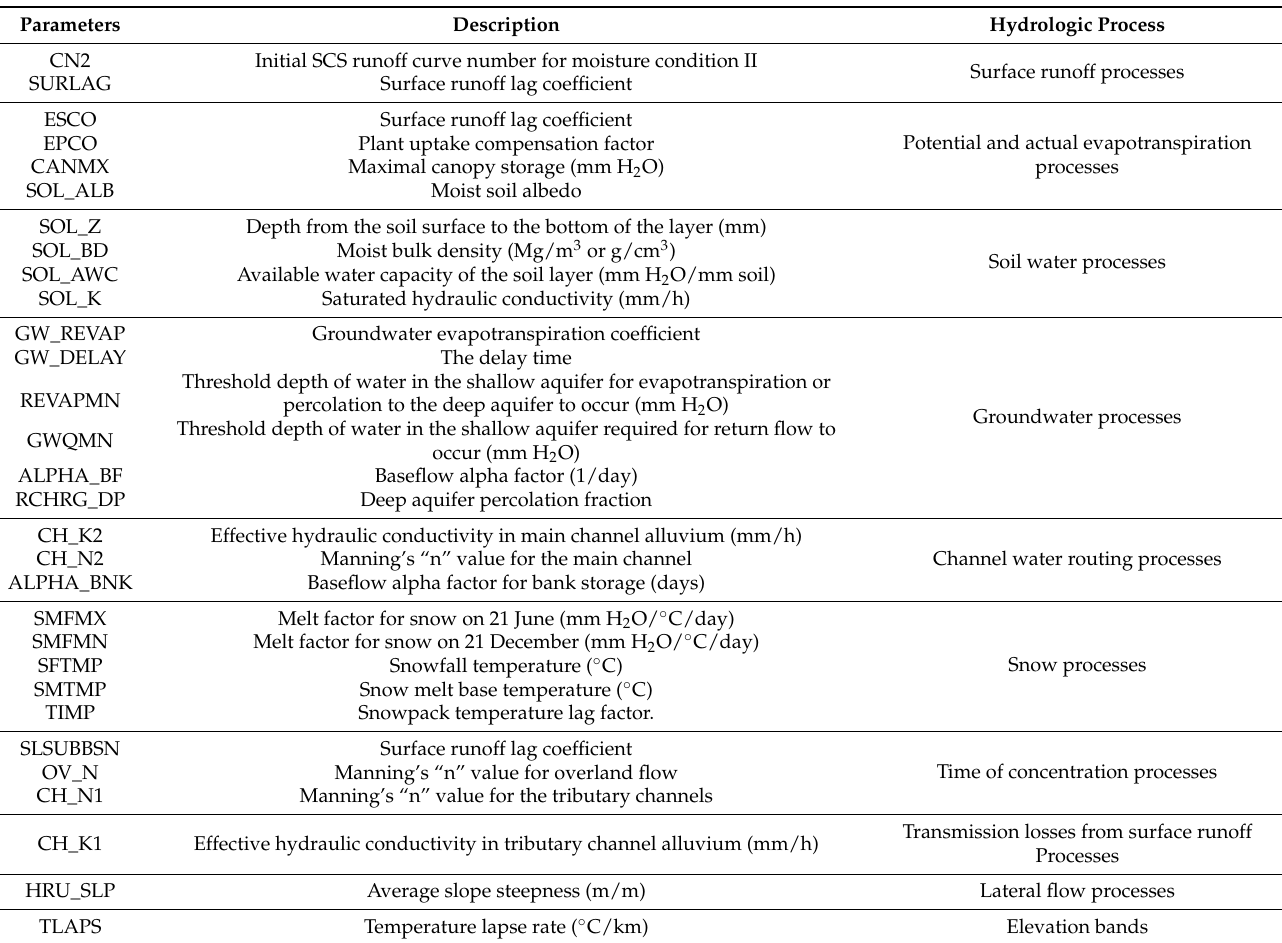
Table 1. Description and hydrological process of 30 selected